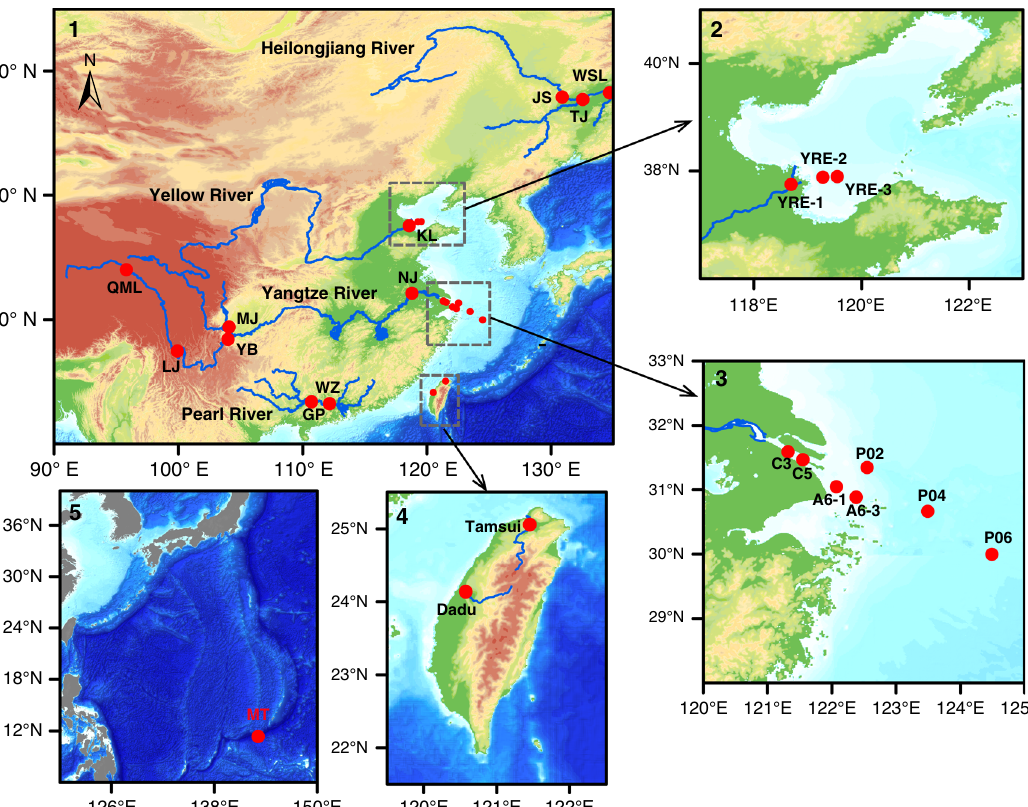
Fig. 6 Map of the study sites and sampling locations. Sampling sites (1) in the four major continental rivers (Pearl, Yangtze, Yellow, and Heilongjiang) in China; (2) the three sites in the Yellow River Estuary; (3) the seven sites in the Yangtze River Estuary and the East China Sea (ECS); (4) the two sites in the two mountainous rivers in Taiwan; and (5) the Mariana Trench (MT) site (11°20.605 ′ N, 142°19.557 ′ E) in the western North Paci fi c